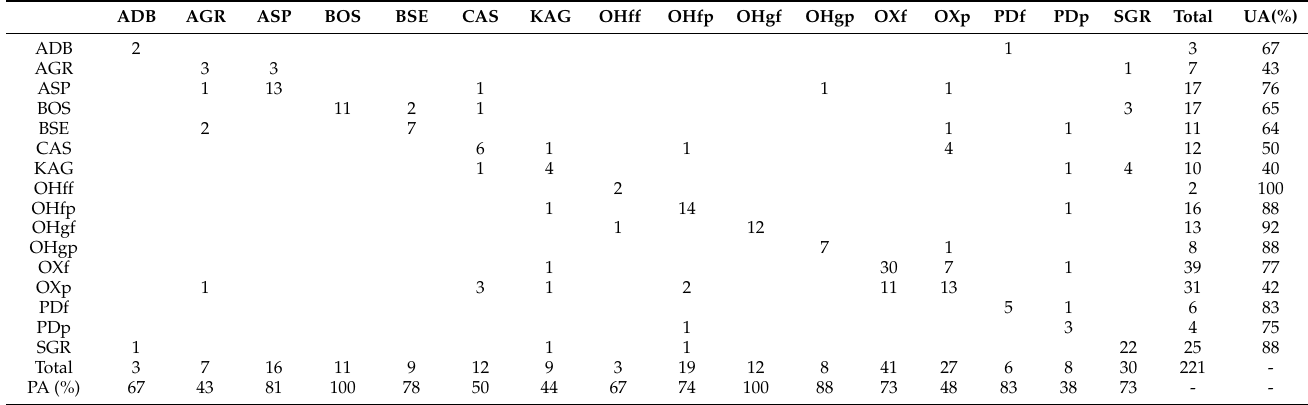
Figure 5. Averaged spectral profiles collected by the spectroradiometer with lens after pre-processing. ( a ) Profiles of the Orange Hawkweed and Ox-eye Daisy; ( b ) Profiles of the weeds versus other co-occurring plants. The important variables (wavelength regions) were highlighted. Table 3. Confusion matrix of the RF classification results of using the spectral profiles collected by the spectroradiometer with lens. (ADB—Alpine daisy bush; AGR—Alpine grevillea; ASP—Alpine shaggy-pea; BOS—Leafy bossiaea; BSE—Black sally; CAS—Sticky cassinia; KGA—Kangaroo grass; OHff—Orange hawkweed in field with flower; OHfp—Orange hawkweed in field with plant; OHgp—Orange hawkweed in greenhouse with flower; OHgp—Orange hawkweed in greenhouse with plant; OXf—Ox-eye daisy with flower; OXp—Ox-eye daisy with plant; PDf—Alpine everlasting with flower; PDp—Alpine everlasting with plant; SGR—Snow grass.; PA—Producer’s Accuracy; and UA—User’s